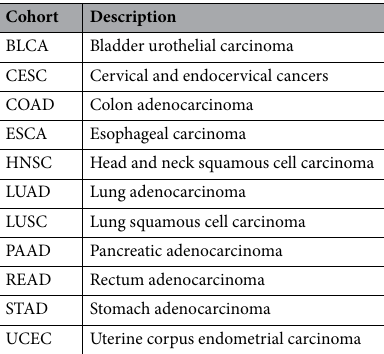
Table 3. Cohorts selected from previous